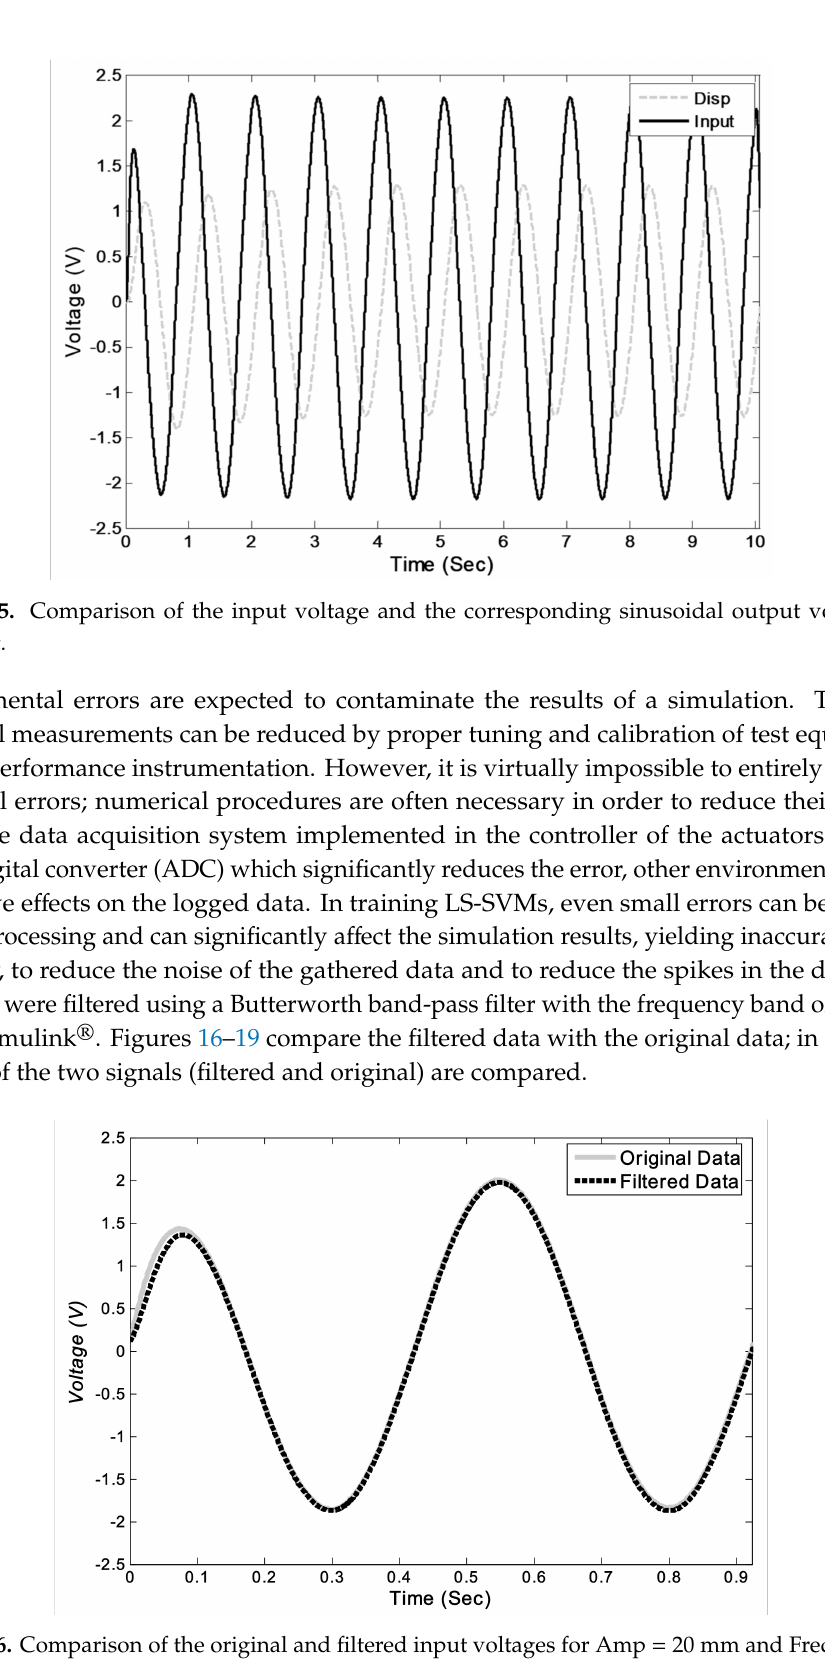
Figure 16. Comparison of the original and filtered input voltages for Amp = 20 mm and Freq = 2